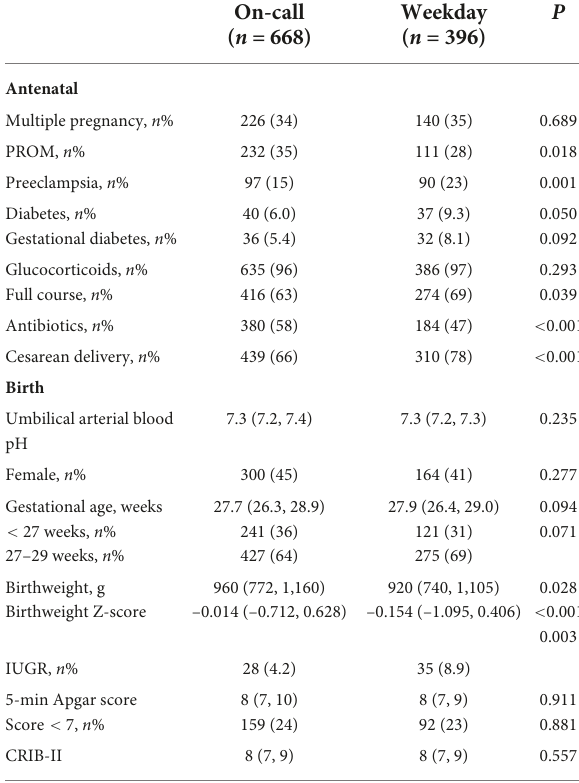
TABLE 1 Perinatal characteristics according to the period of